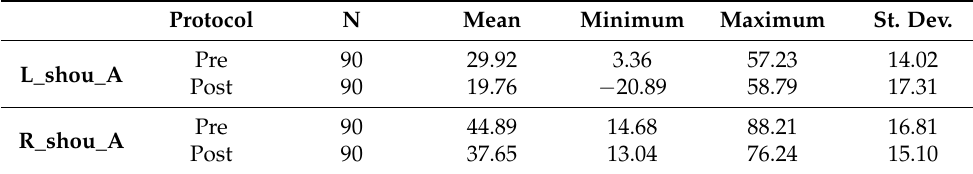
Table 2. Basic descriptive indicators of the observed kinematic parameters during the performance of the ISN